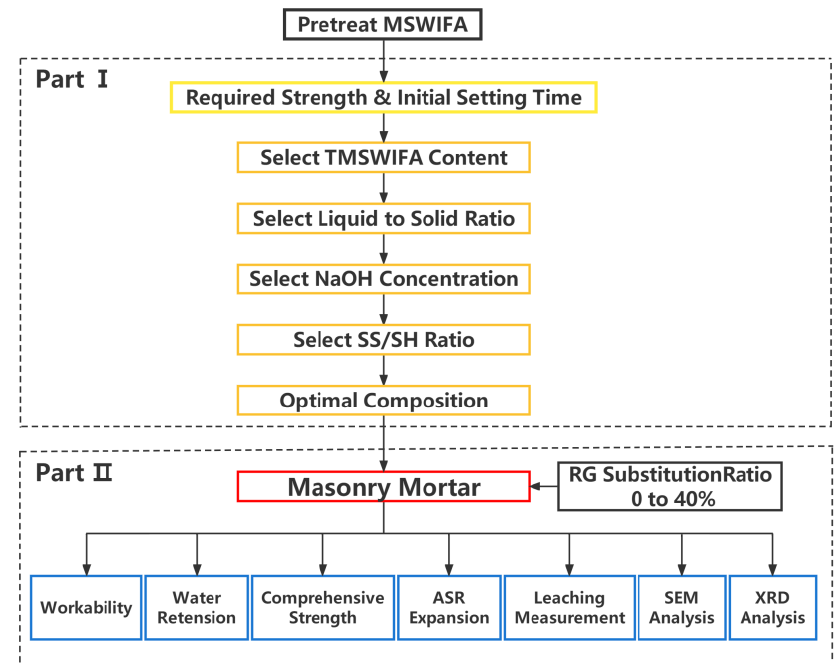
Figure 1. Research